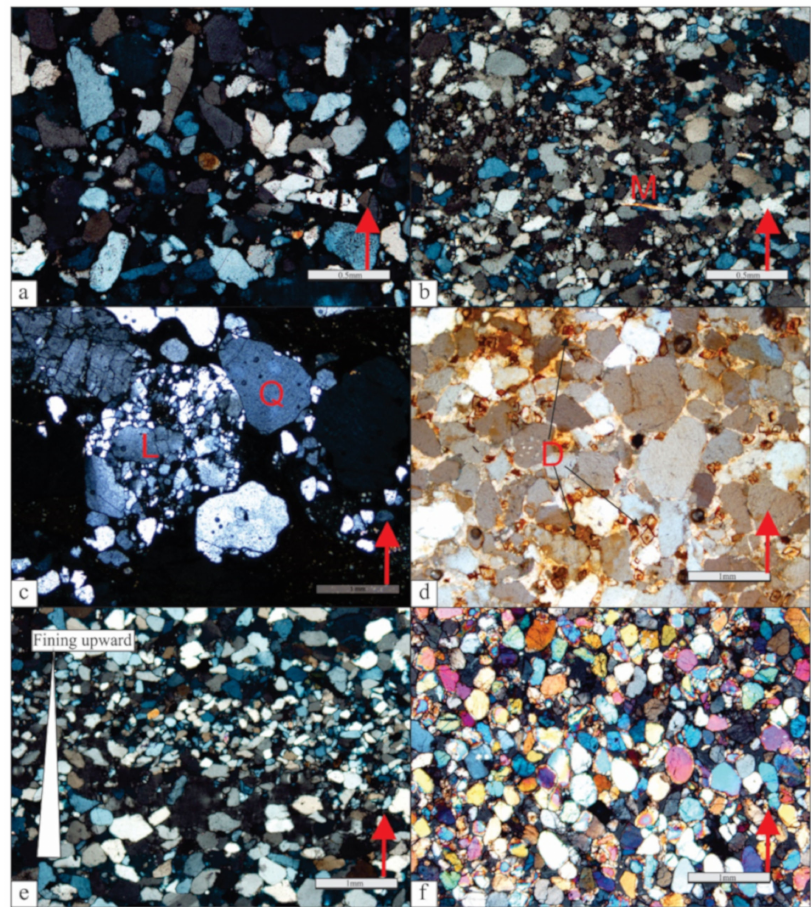
Figure 6. Representative thin section photomicrographs of the Kingriali and Datta formations siliciclastics. ( a ) Poor to moderately sorted, angular to subangular medium grained quartz rich sandstone with matrix and Fe-cement in the Kingriali Formation (Kasanwala); ( b ) subangular to subrounded poorly sorted fine grained sandstone of the Kingriali Formation (Kasanwala); ( c ) quartz- rich lithoclasts in well-rounded and very well sorted, pebbly sandstone of the Datta Formation (Nammal Gorge); ( d ) quartz-rich sandstone with carbonate cement and dolomite rhomb in the Datta Formation (Kasanwala); ( e ) fining upward cycle in quartz-rich sandstone at Gulla Khel; and ( f ) very well rounded and very well sorted quartz-rich sandstone in the Datta Formation (Nammal Gorge). Red arrow in each case indicates the top of bed. D = dolomite crystal; L = lithoclast; M = mica; Q =